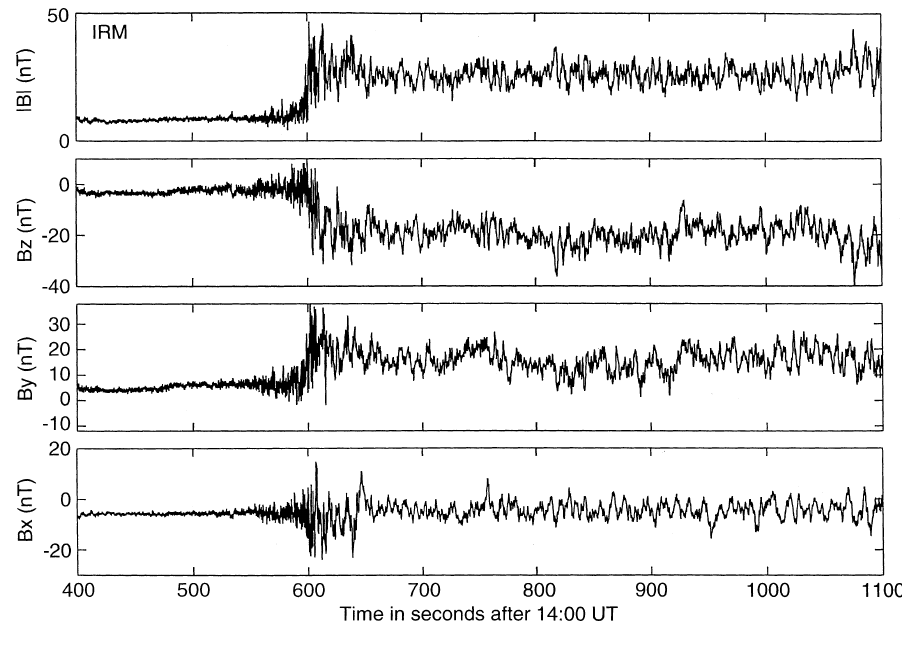
Fig. 2. Absolute value and three components of magnetic field mea- sured by AMPTE IRM during bow shock crossing which occurred at